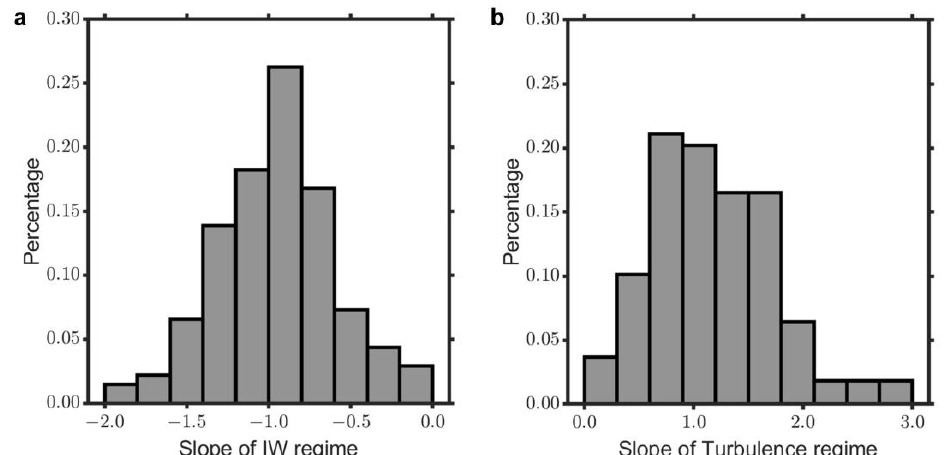
Figure A1. The histogram of the slopes of best-fitting lines in the subrange of ( a ) internal wave and ( b ) turbulence.